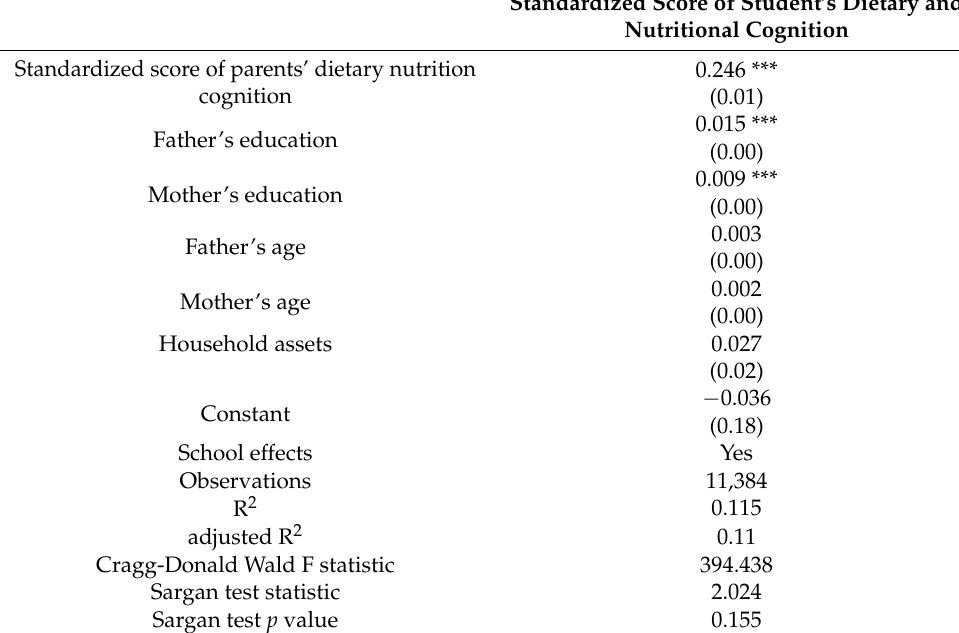
Standardized Score of Student’s Dietary